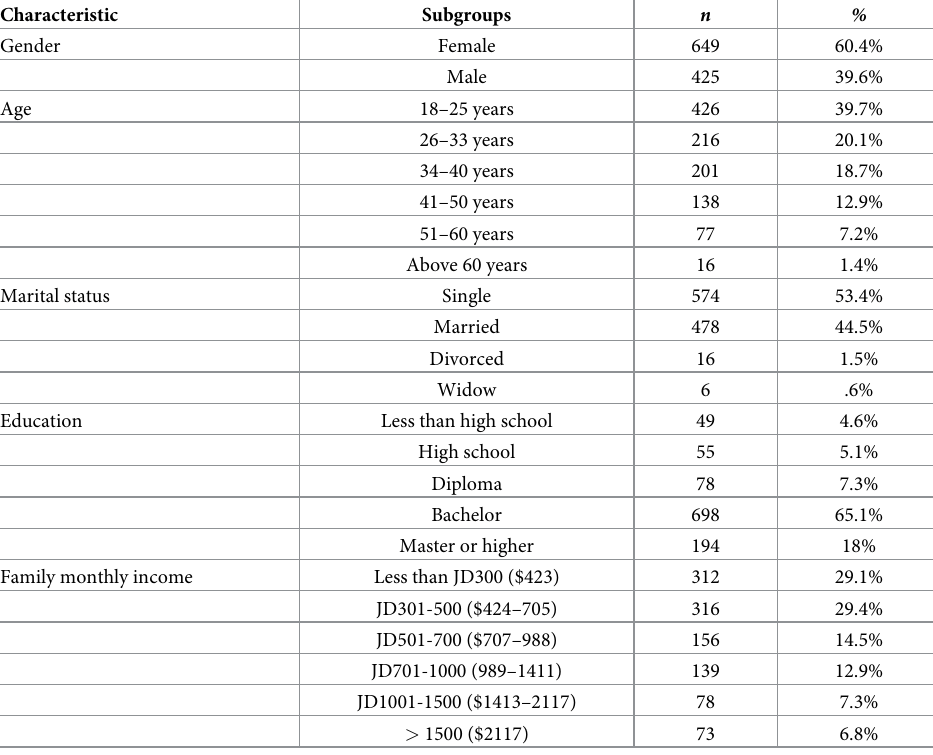
Table 1. Participants’ demographic characteristics (N =